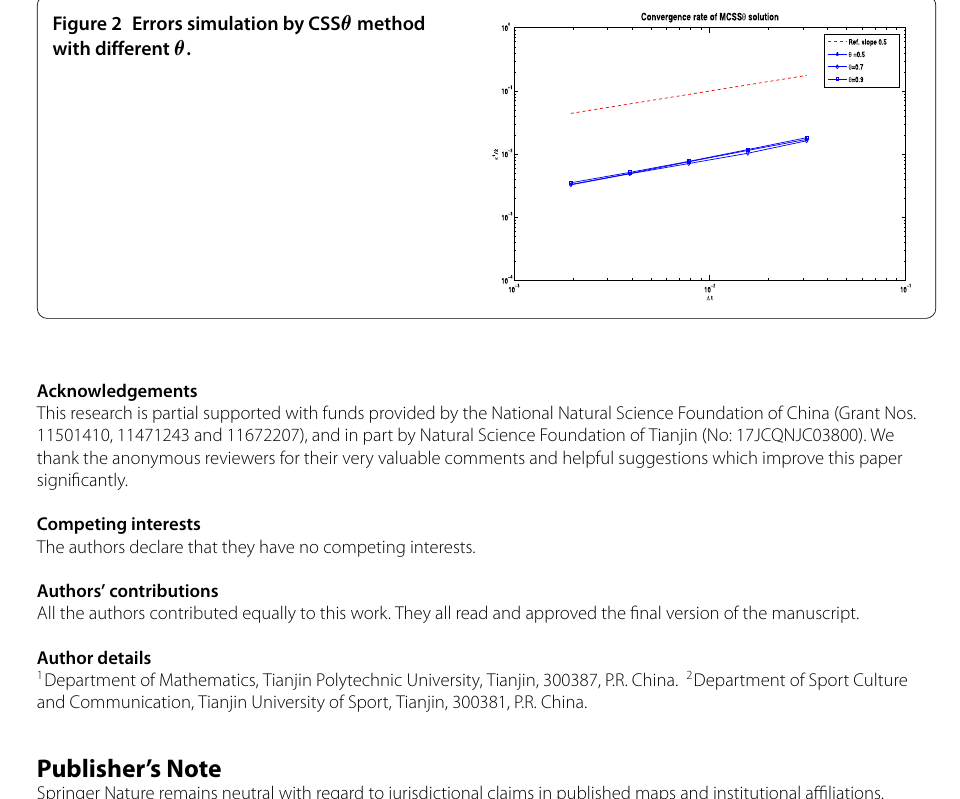
Figure 2 Errors simulation by CSS θ method with different θ